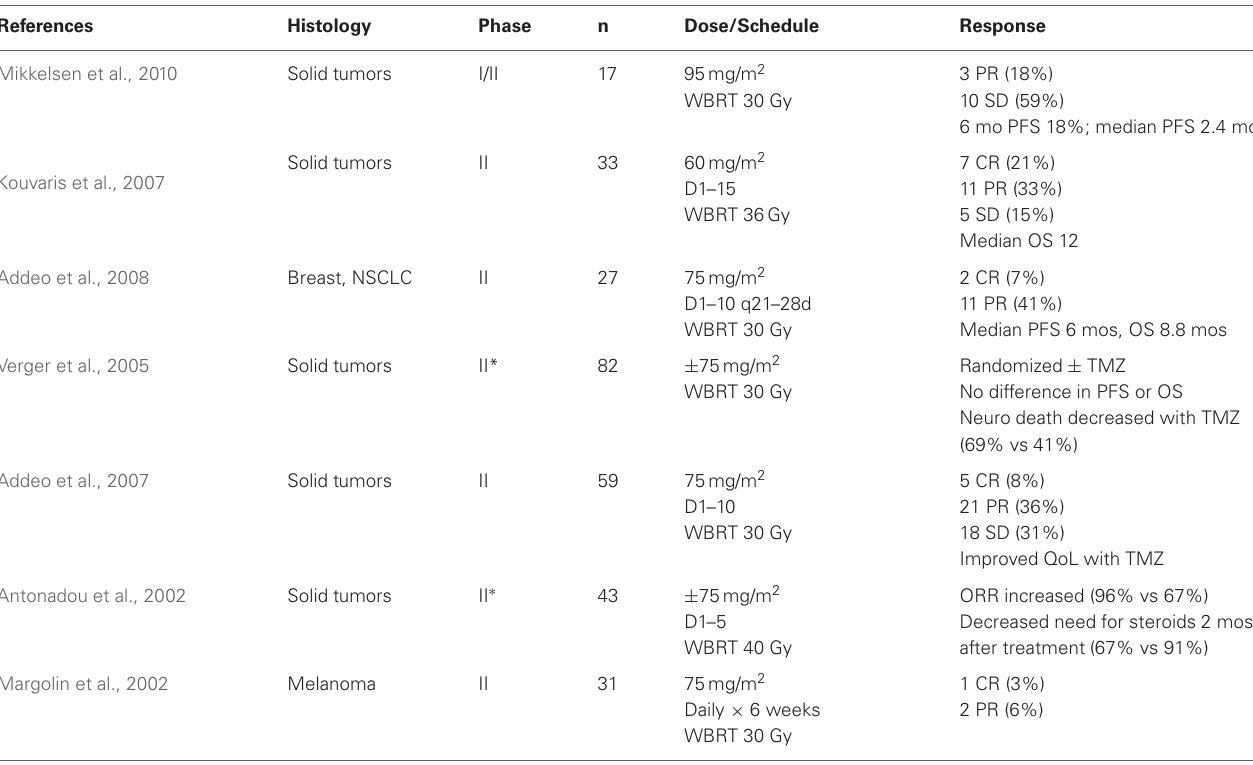
Table 3 | Results with TMZ and WBRT for established brain